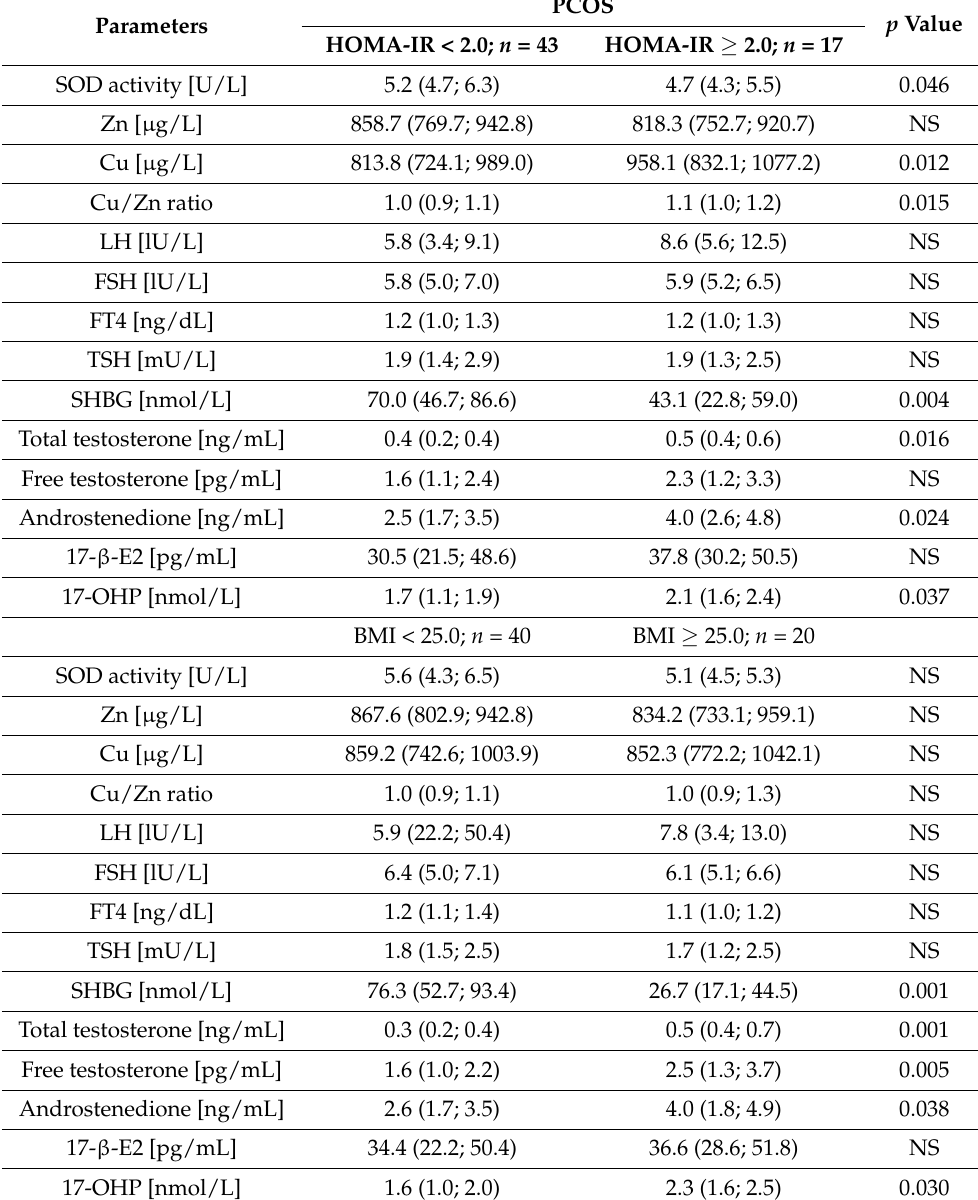
Table 2. Comparison of analyzed parameters in the group of women with PCOS divided according to the value of HOMA-IR or